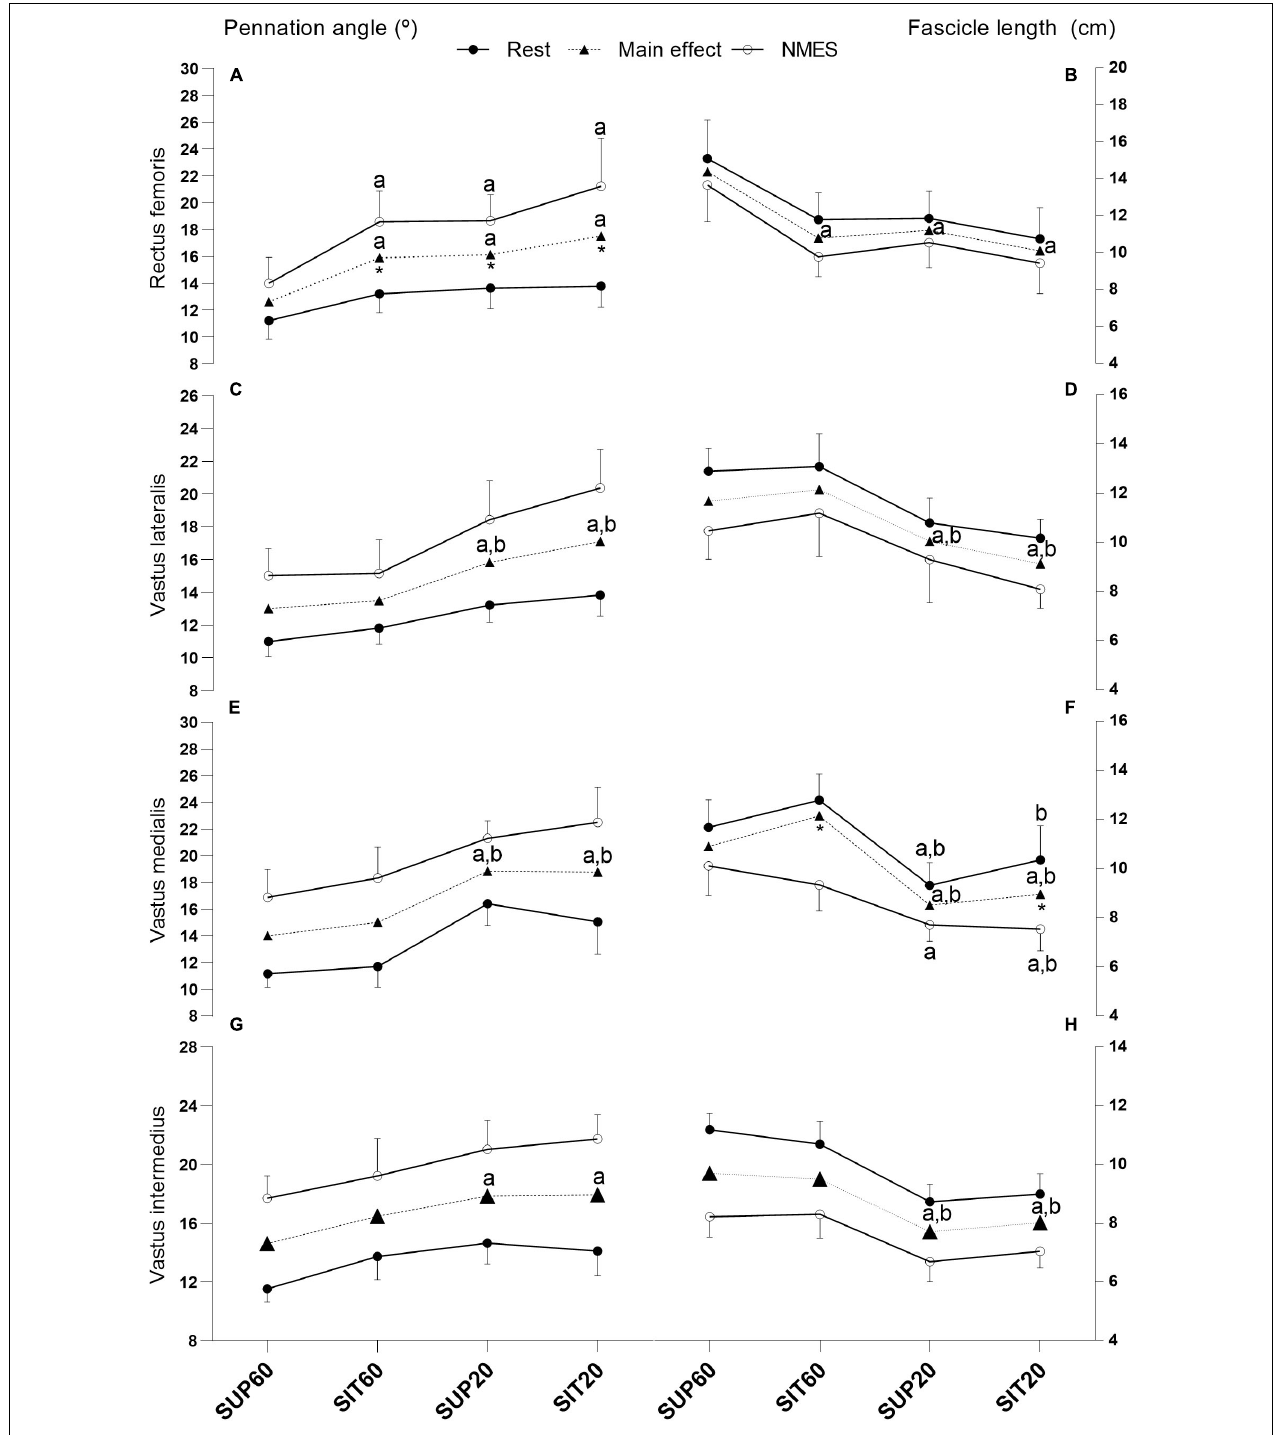
FIGURE 4 | Muscle architecture changes of the quadriceps femoris constituents in different muscle lengths according to hip and knee angles at rest and during NMES: Pennation angle (left y axis) and fascicle length (right y axis) of all constituents of the quadriceps femoris individually and grouped at rest, during NMES (continuous lines), and main effect of position (dotted lines). Data are presented as mean and 95% CI. (A,B) Rectus femoris - (C,D) Vastus lateralis - (E,F) Vastus medialis- (G,H) Vastus intermedius . Legend: NMES, neuromuscular electrical stimulation; SUP60, supine with 60 ◦ of knee flexion; SIT60, seated with 60 ◦ of knee flexion; SUP20, supine with 20 ◦ of knee flexion; SIT20, seated with 20 ◦ of knee flexion, where supine was 0 ◦ of hip extension, seated was 85 ◦ of hip flexion, and full knee extension. Statistically significant differences: a different from SUP60; b different from SIT60. *Indicate significant difference ( p ≤ 0.05) between rest and MEIC when there was a position by time effect. The significance threshold was set at α <